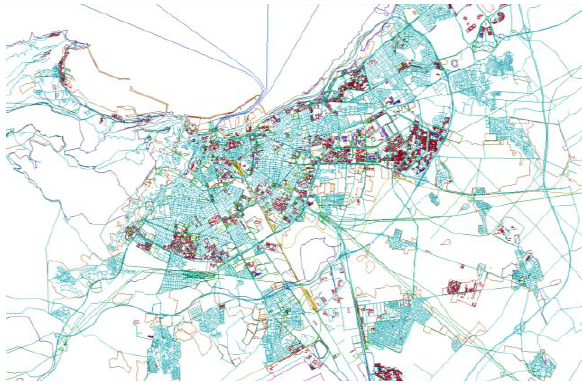
Figure 1. OSM and reference data